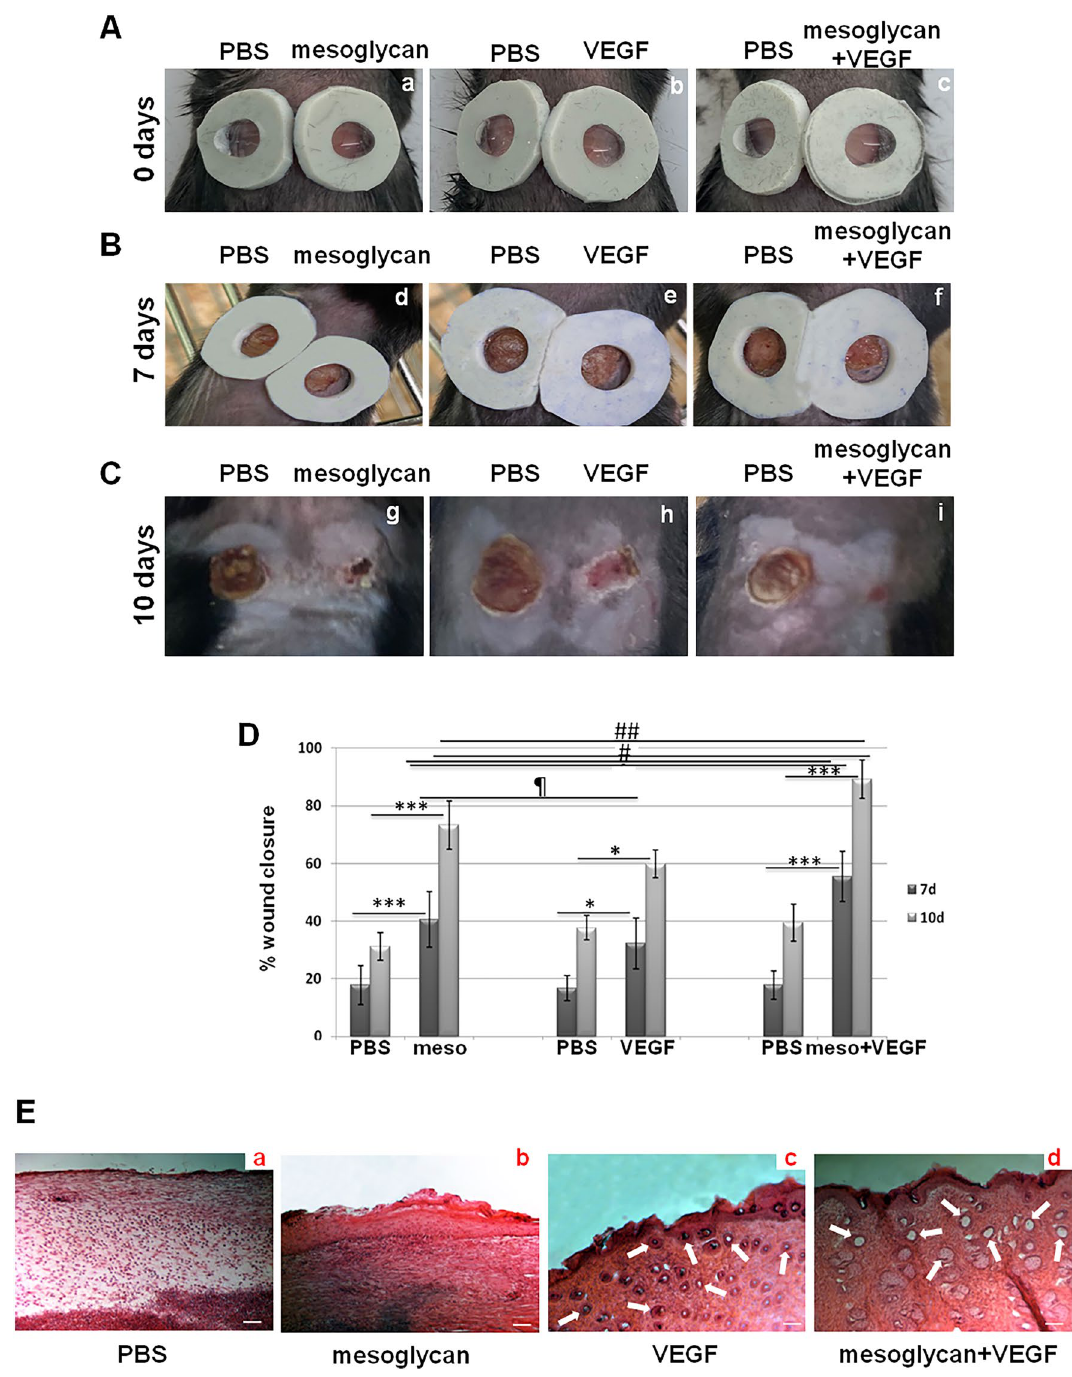
Figure 2. Excisional skin wounds on C57BL6 mice were macroscopically photographed at the indicated time ( A ) the day 0 pictures have been taken immediately after injury, panels a–c; ( B ) the day 7 of treatments has been represented by panels d–f; ( C ) the day 10 refers to the sacrifice, panels g–i. Representative results from five individual mice from each group are shown. ( D ) Wound areas measurements at day 10 calculated as percentage as differences with the diameter of the related lesions at day 0. The data represent a mean of n = 3 independent experiments ± SD based on one-way ANOVA and a two-tailed Student’s t -test as appropriated; *p < 0.05, ***p < 0.001 versus PBS treated controls; # p < 0.05; ## p < 0.01 for combination versus mesoglycan or VEGF treated wounds; ¶ p < 0.05 for VEGF treatment versus mesoglycan one. ( E ) Skin sections harvested at day 10 have been stained through H&E (panels a–d). White arrows indicate new blood vessels. Magnification ×10. Bar = 100